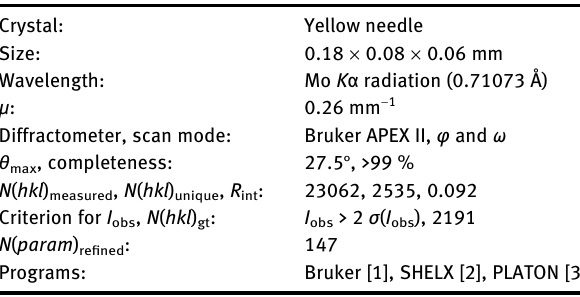
Table  : Data collection and